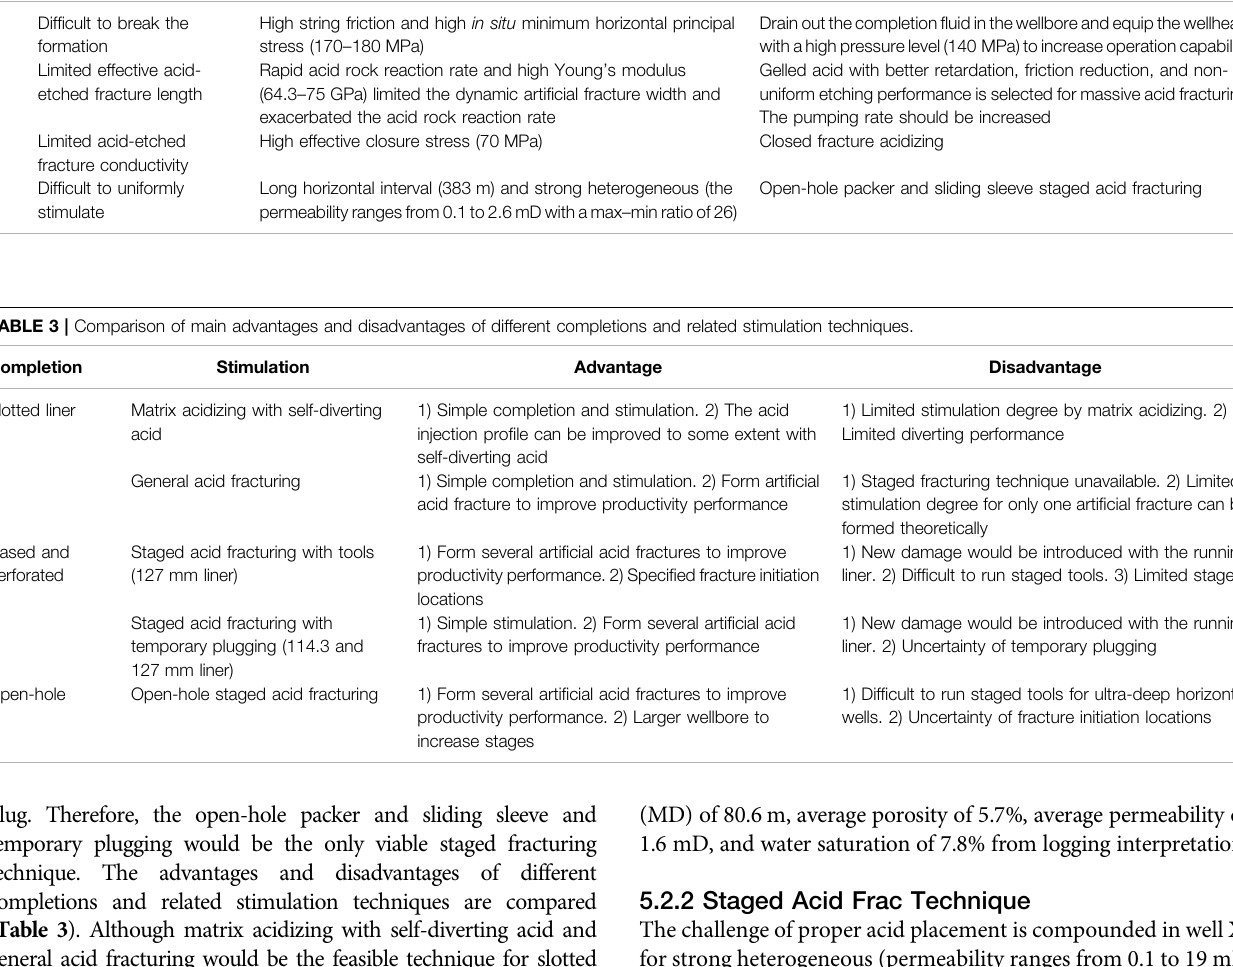
TABLE 2 | Dif fi culties and countermeasures of staged acid fracturing for well M. No.